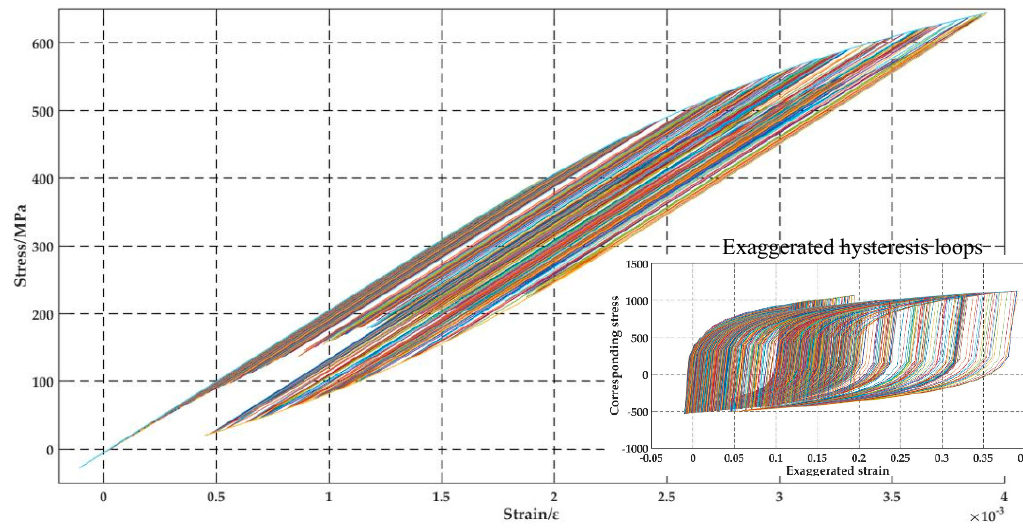
Figure 12. Strain stress response curve (testing point 3#).